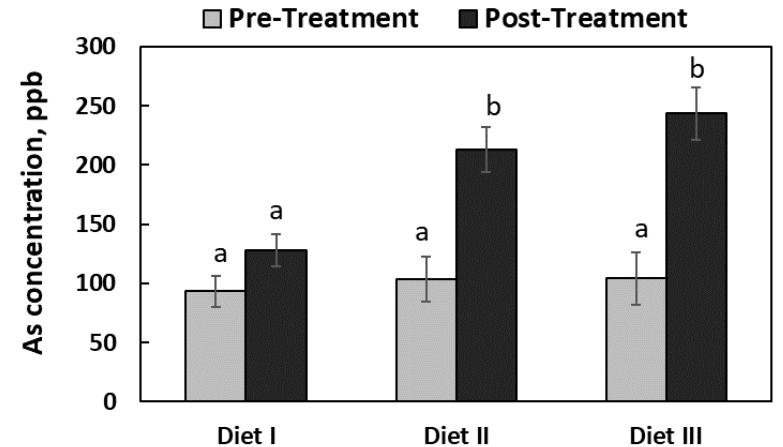
Figure 1. The concentrations of arsenic (As, as-is basis) in the feces of the pigs fed with three experimental diets. The rectangular bars represent the pattern of mean As concentrations in the feces before and after the feeding trial (pre- and post-treatment; n = 6 for Diet I, and n = 7 for Diets II and III). The error bars represent the pooled standard error of the means. The means labeled with different letters (a, b) differ ( p < 0.05).